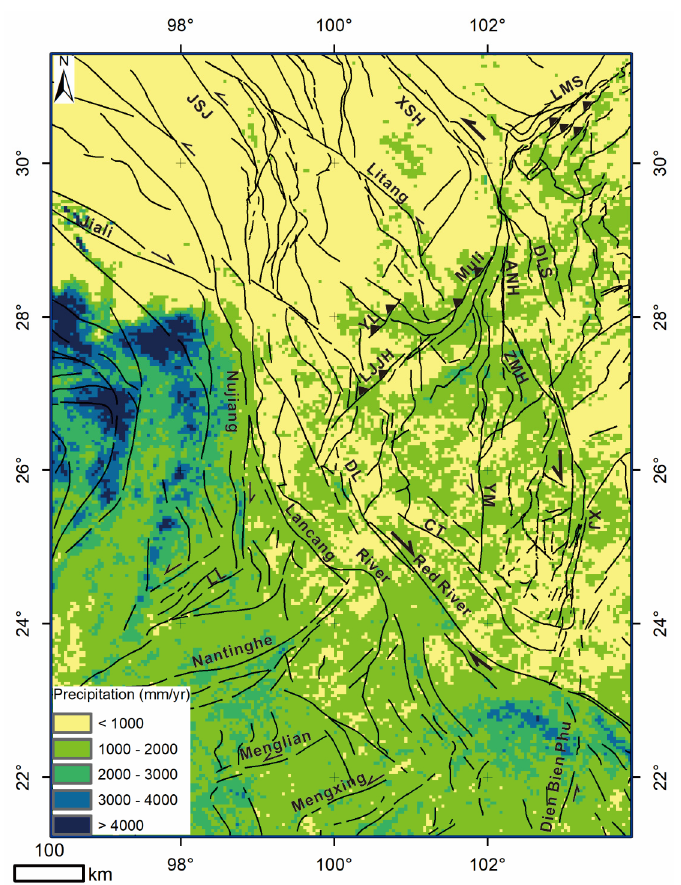
Figure 8. Mean precipitation derived from TRMM data (1997–2006). The maximum rainfall was blocked by the high topography of the Tibetan Plateau and occurred mainly in the west of the Nujiang fault and the southeast of the Red River fault. Topography also plays an important role as the precipitation decrease to less than 1000 mm/year in the high plateau area.